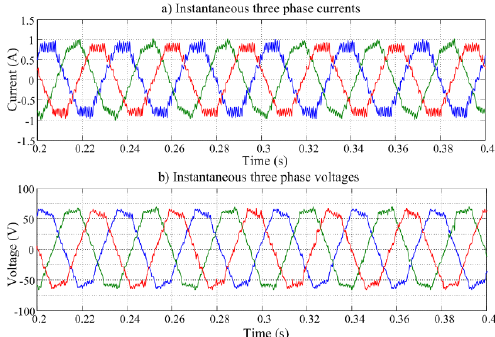
Figure 21. Instantaneous 3phase currents and voltages.